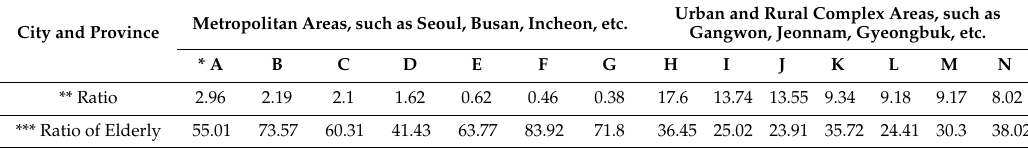
Table 4. Proportion of guiding service objects and elderly objects by city and province. City and Province Metropolitan Areas, such as Seoul, Busan, Incheon,